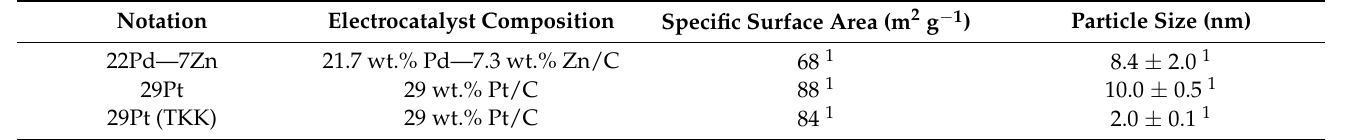
Table 1. Specific surface area (SSA) and particle size of the tested